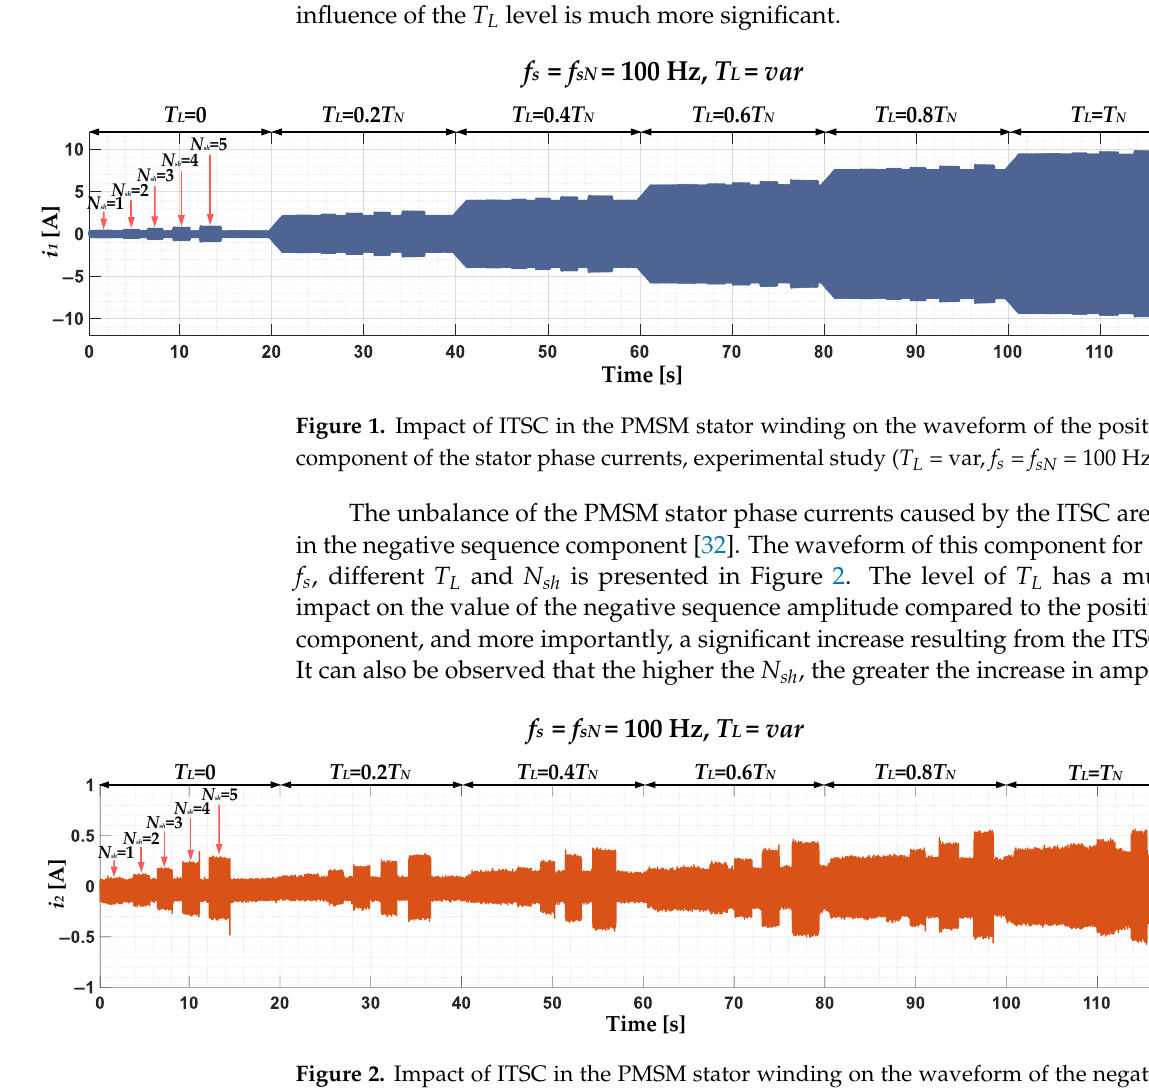
Figure 2. Impact of ITSC in the PMSM stator winding on the waveform of the negative sequence component of the stator phase currents, experimental study ( T L = var, f s = f sN = 100 Hz).